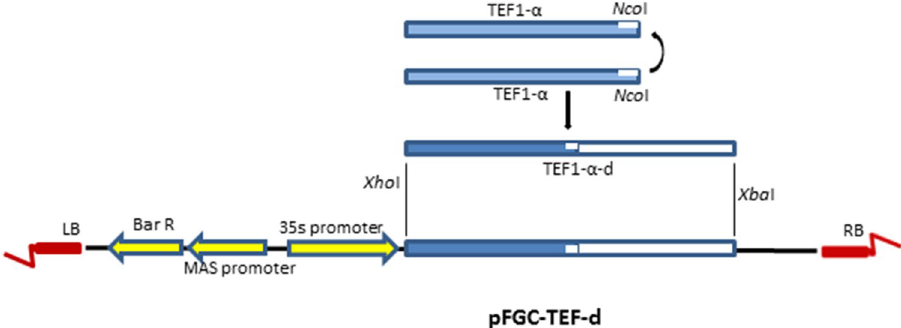
Figure 1. Schematic figure of cloning steps of Tef-1α into a binary